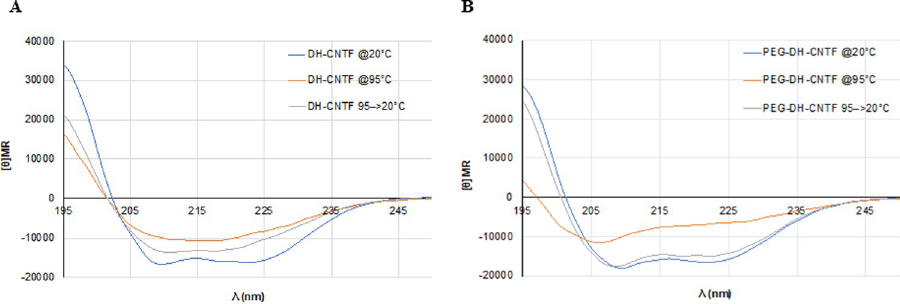
Fig 3. CD analysis of DH-CNTF and PEG-DH-CNTF at different temperatures. CD spectra were recorded at 20˚C, 95˚C and after cooling the samples from 95˚C to 20˚C. Samples were solubilized in water.